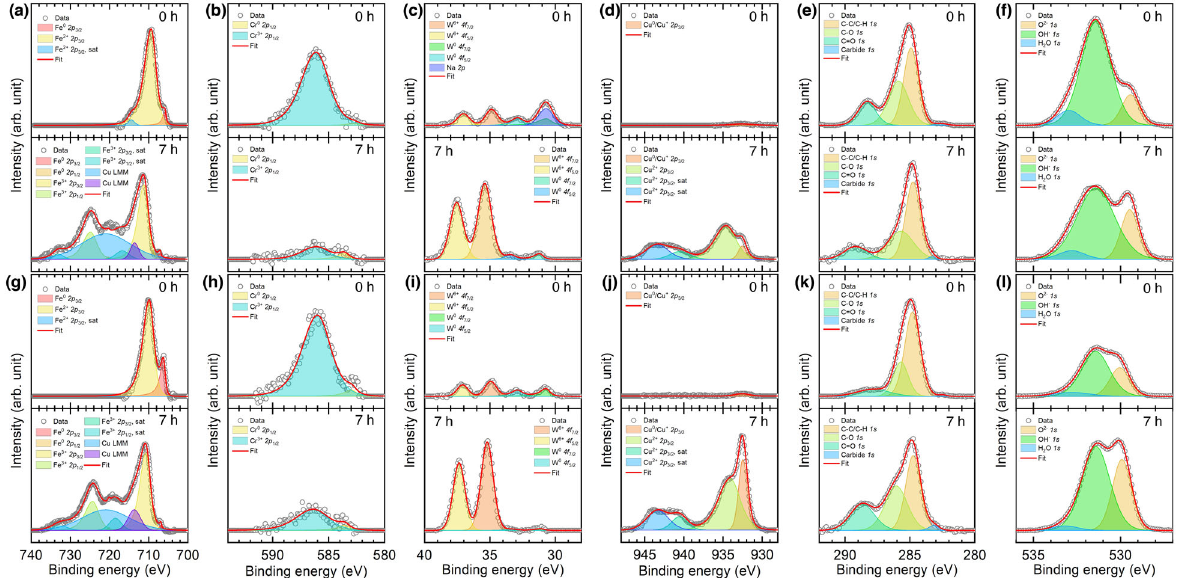
Fig. 6 High-resolution XPS pro fi les at different immersion durations. a , g Fe 2p , b , h Cr 2p , c , i W 4f , d , j Cu 2p , e , k C 1s , and f , l O 1s peaks obtained for the outermost surfaces of the 16Cr steel samples heat treated at a – f 800 °C and g – l 1100 °C before and after the 7-h immersion in the 0.5 M H 2 SO 4